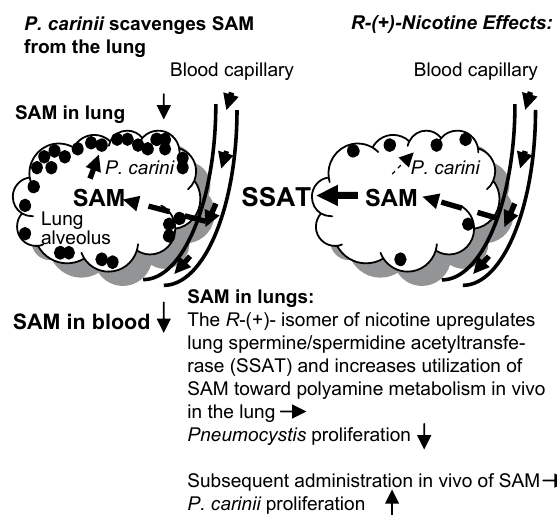
Fig. 1. – Proposed utilization and metabolism of S -adenosylmethionine (saM, adoMet) in the P. carinii -infected rat lung according to Merali &